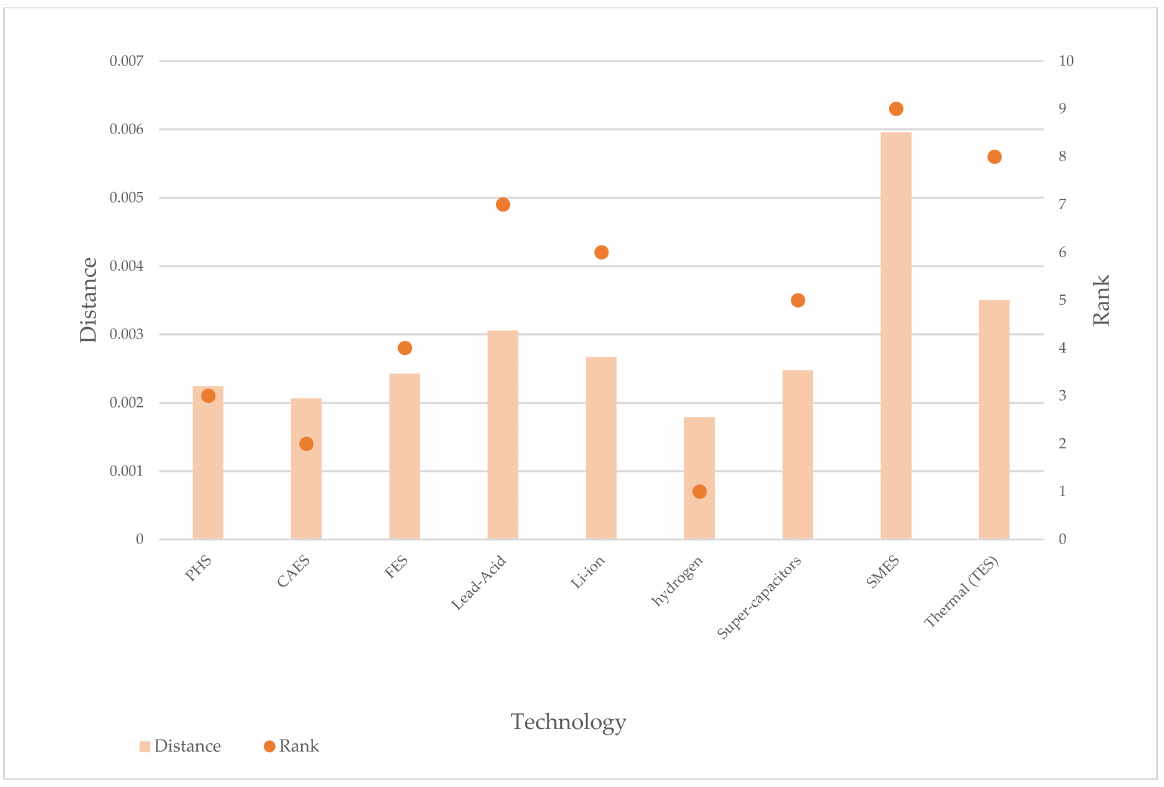
Figure 6. The distance calculation and ranking results in Scenario